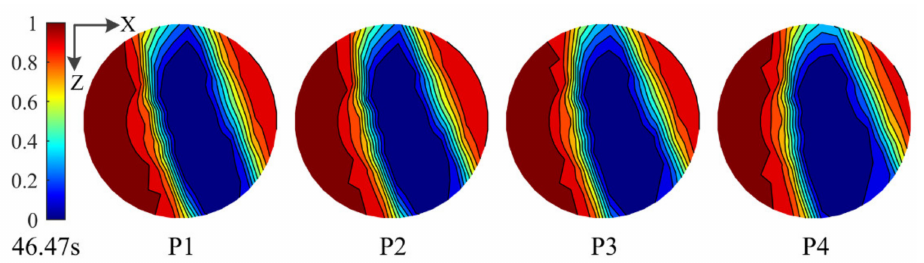
Figure 23. The compression damage of concrete in the core area at 45.39 s.